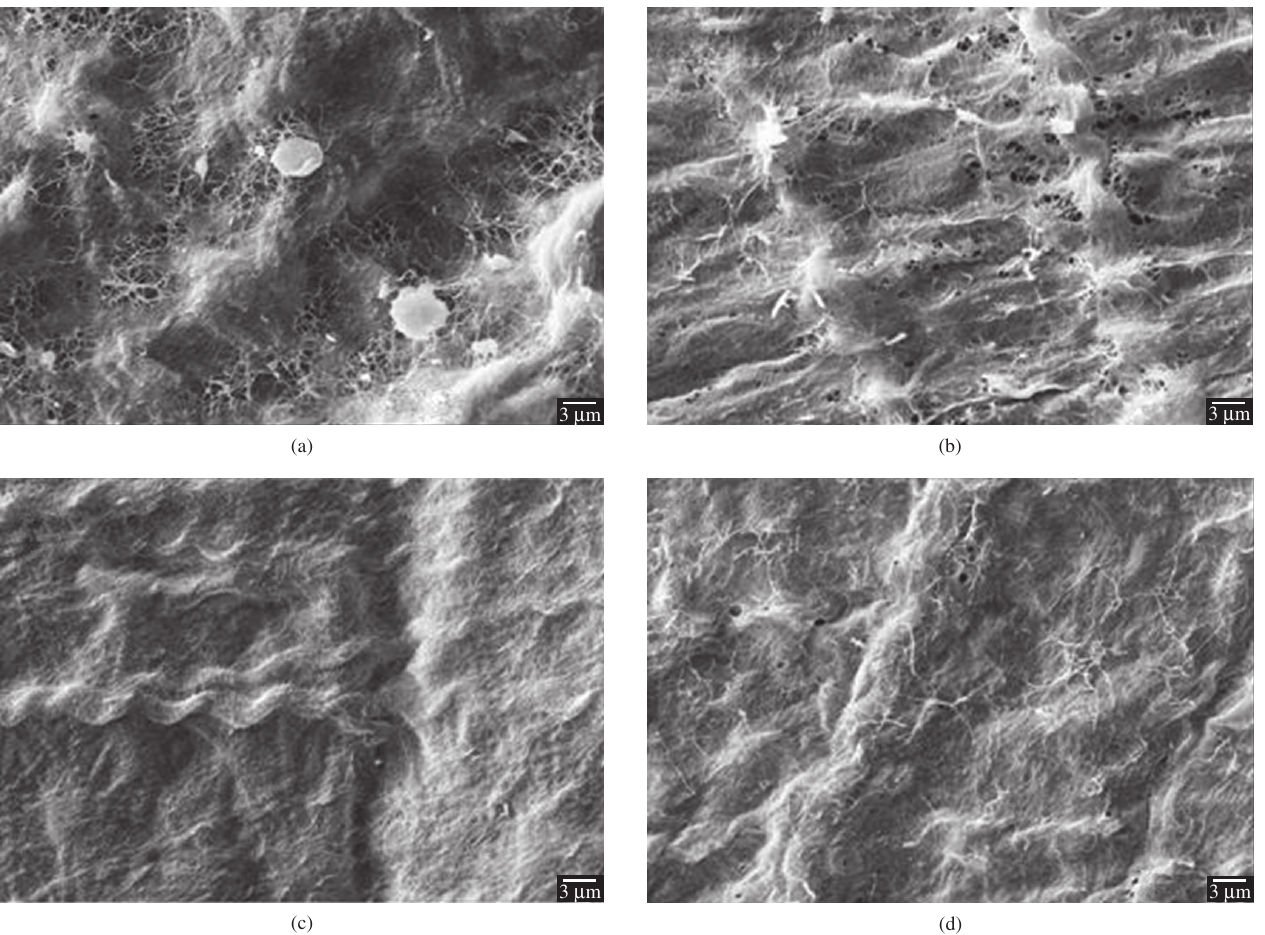
Figure 3. Scanning electron microscopy of bovine pericardium after crosslinking with glutaraldehyde (GA): a) 0.5% GA for 10 days; b) 0.5% GA for 10 days + glutamic acid/borate buffer; c) Pretreatment with GA 0.05% + 0.5% GA for 10 days; and d) Pre-treatment with GA 0.05% + 0.5% GA for 10 days + glutamic acid/borate